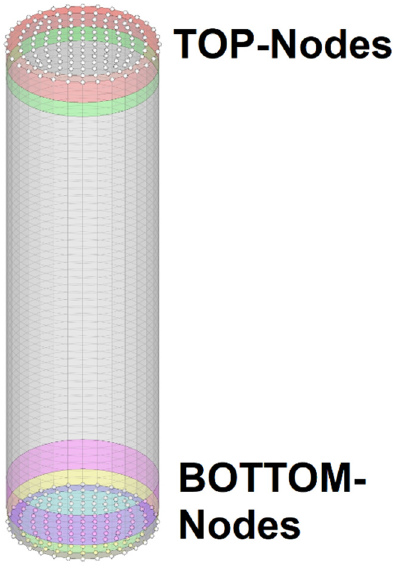
Figure 16. Cell model with the top and bottom nodes used for the axial geometric criterion. The radial geometric criterion is based on the distance between pairs of nodes located on directly opposite points of the cell-cylinder mantle. All nodes on the cylinder mantle are used and, altogether, 1008 pairs of nodes are defined. An example of such a pair is shown in Figure 17.